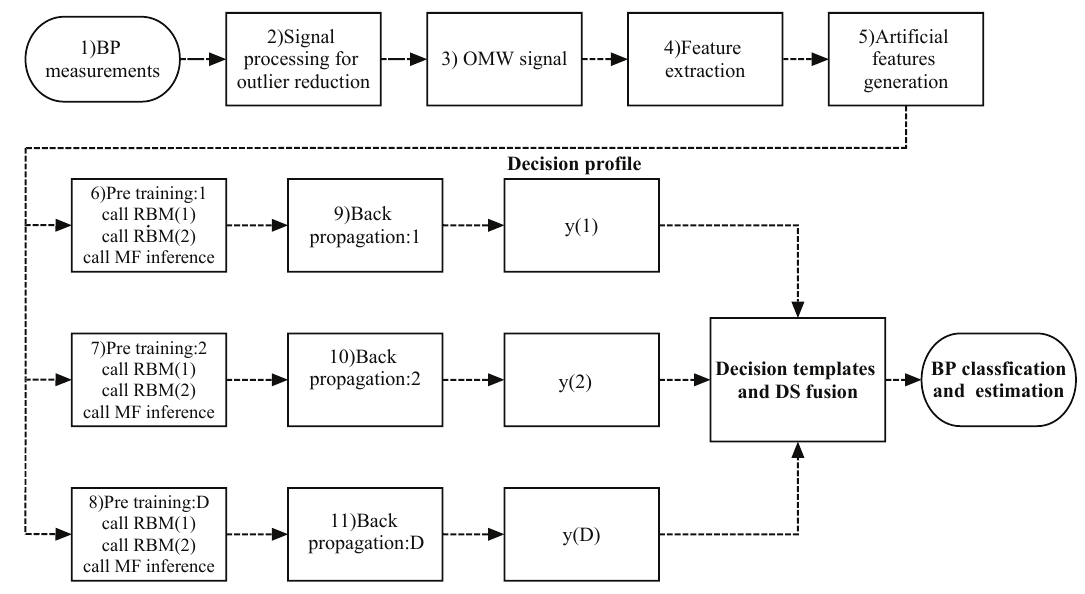
Figure 1. Upper boxes: Procedures of BP (blood pressure) measurement, signal processing, oscillometric wave (OMW) signal, feature extraction, and artificial features generation. Right boxes (6 to 11) are DBMs (deep Boltzmann machine). Other boxes: DS (Dempster–Shafer) fusion to decrease uncertainty, where y ( 1 ) is the output vector of the first classifier, and D represents the number of classifiers. DS fusion is further explained in Section